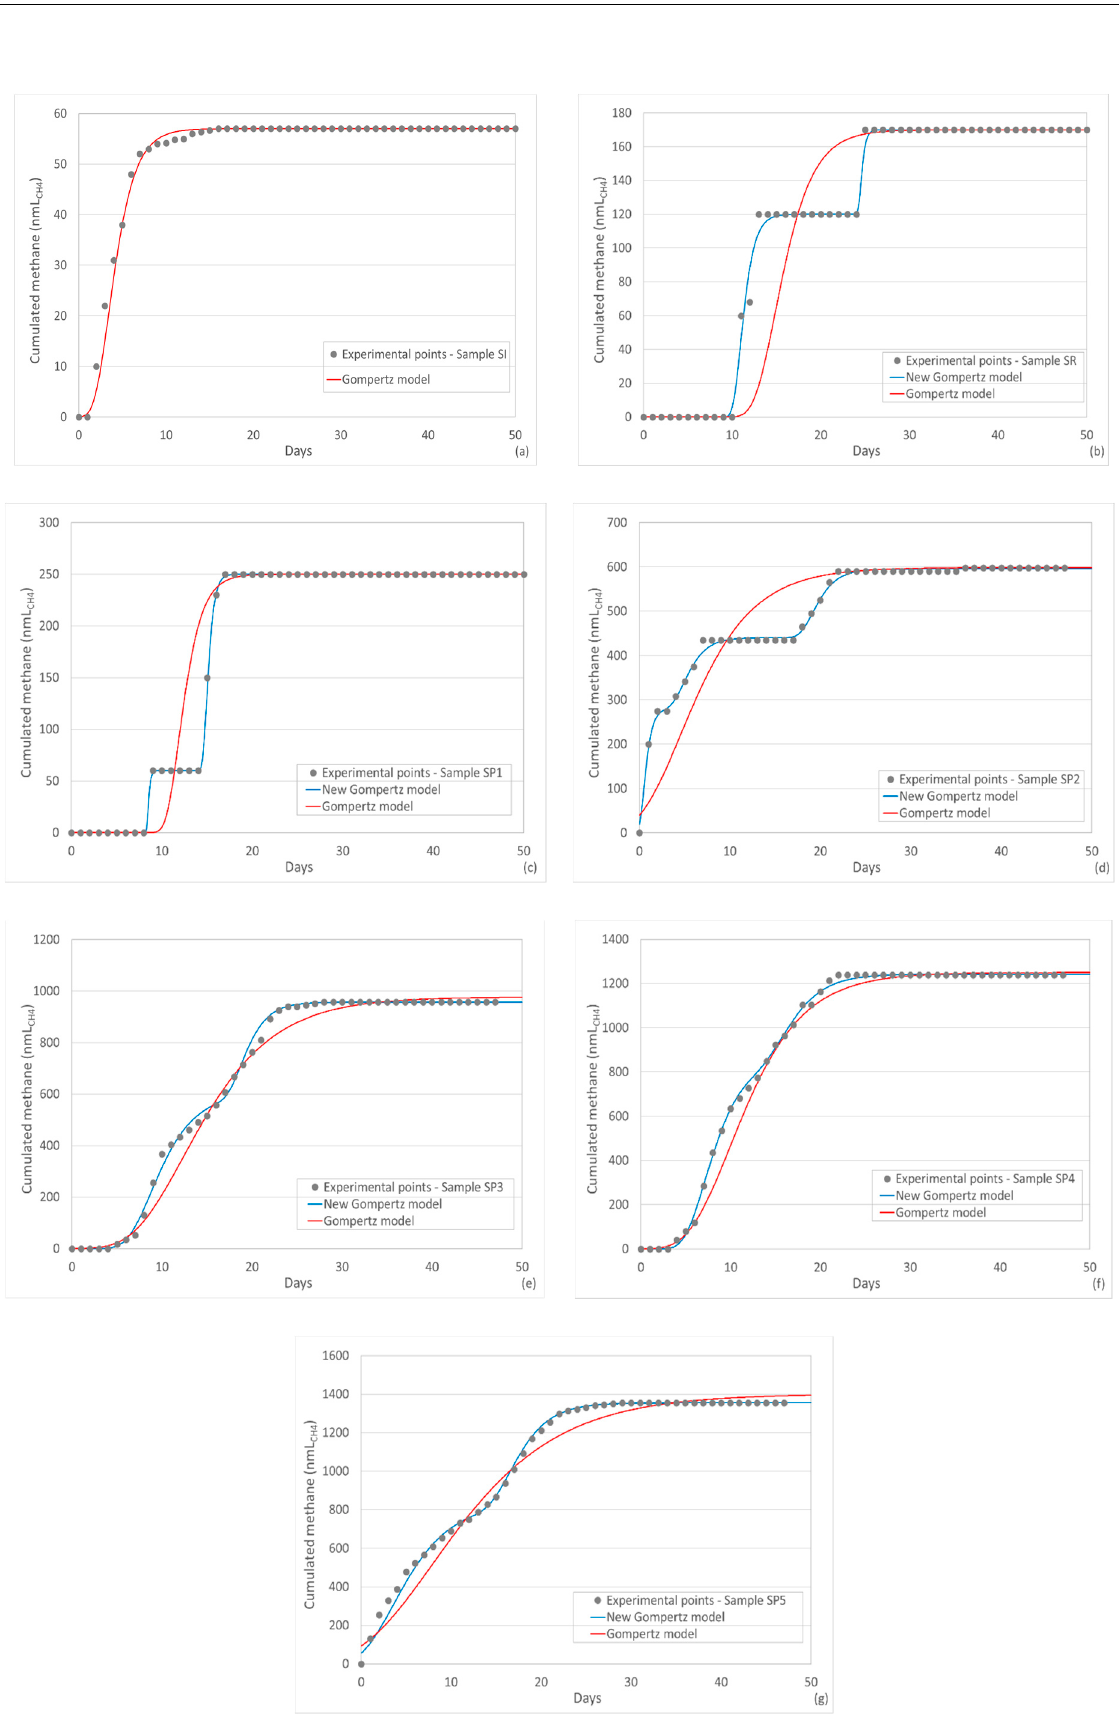
Figure 6. Interpolation of experimental curves through the Gompertz equation (Equation (8)) and the new proposed model (Equation (9)): mixtures SI ( a ), SR ( b ), SP1 ( c ), SP2 ( d ), SP3 ( e ), SP4 ( f ), SP5 ( g ).